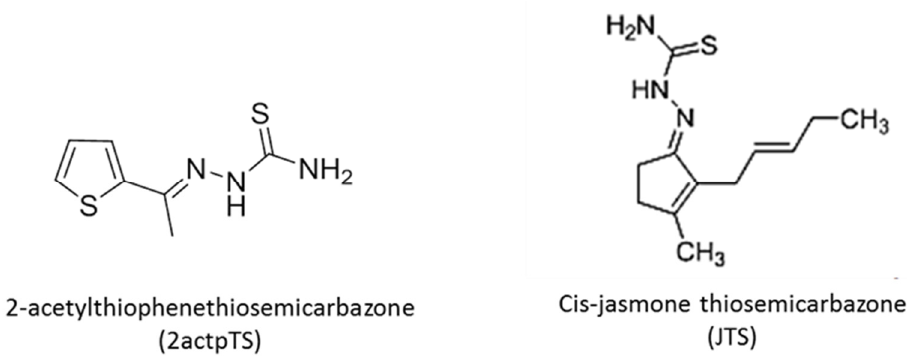
Figure 1. Schematic representation of the structures of the two thiosemicarbazone derivatives used in this study (2actpTS and JTS).